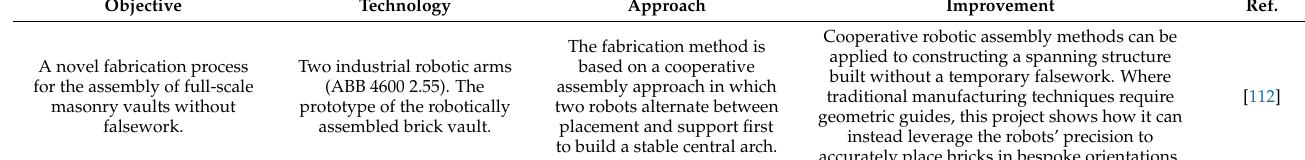
Table 8. Research focused on implementing robots in the construction and civil engineering